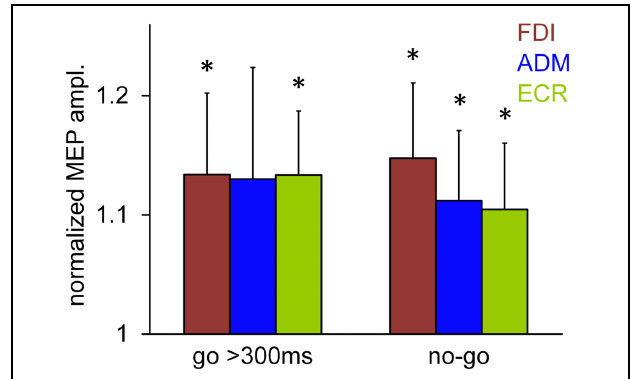
FIGURE 6 | Normalized mean MEP amplitudes recorded in the ‘go’ trials with a TMS delay of 120 ms and a saccade latency greater than 300 ms, compared to the responses observed in the ‘no-go’ trials recorded at the same TMS delay after stimulus presentation. Bars represent the standard error of the mean. Asterisks indicate that the values are significantly greater than baseline (one-sample t -test; P <